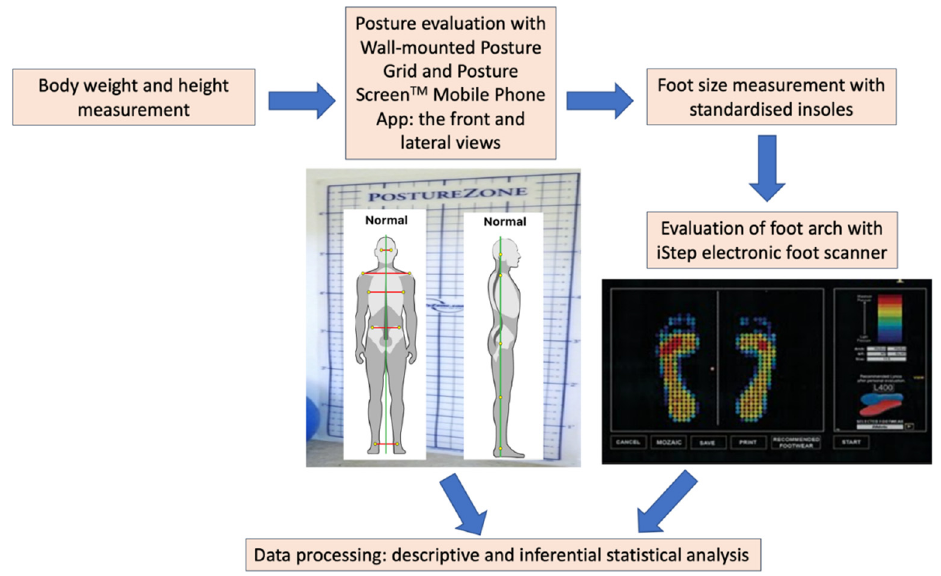
Figure 4. The investigation protocol for foot arch and posture